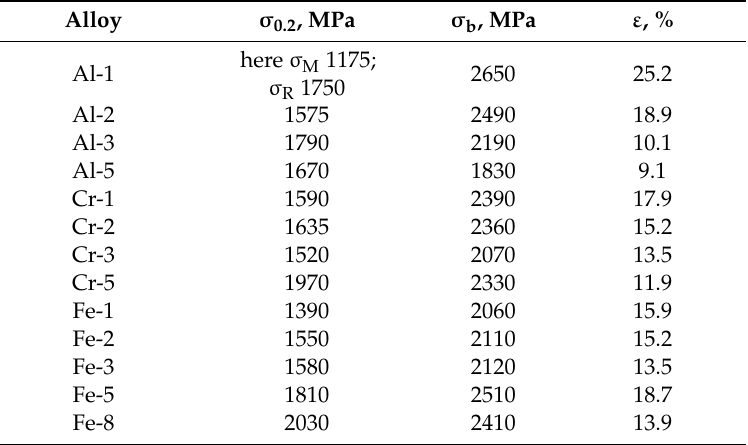
Table 3. Mechanical properties of the studied